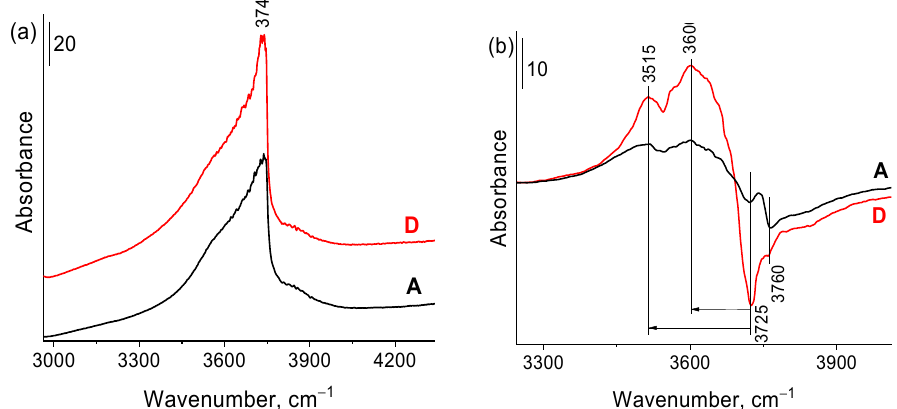
Figure 7 . ( a ) FTIR spectra of samples A and D at room temperature in the absorption region of hydroxyl groups and ( b ) differential FTIR spectra of OH groups after CO adsorption on samples A and D .